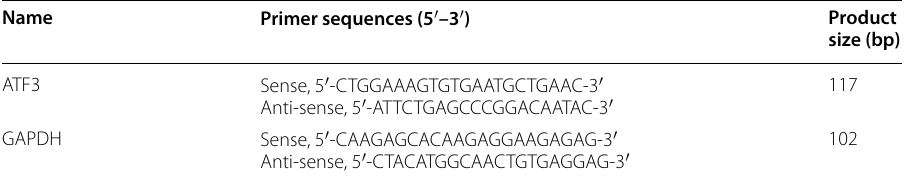
Table 1 Primer sequences of qRT-PCR